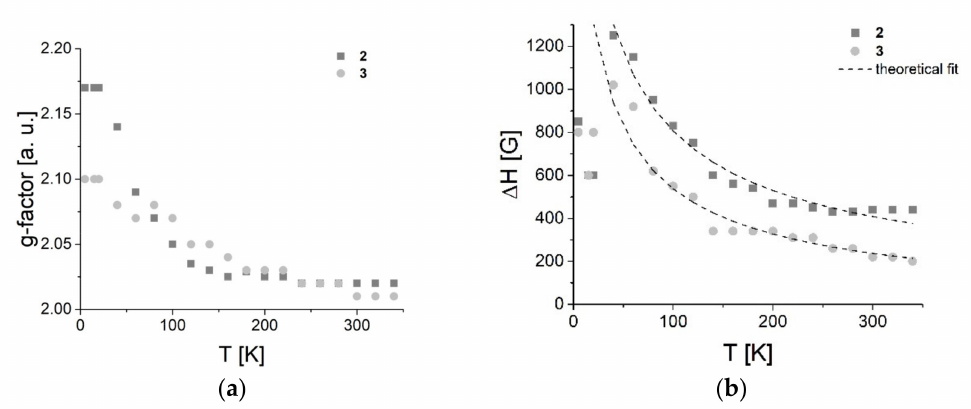
Figure 8. The temperature dependences of the resonance magnetic field ( a ) and line width ( b ) of III-type HS Fe(III) centers in 2 and 3 . The dashed lines show the theoretical